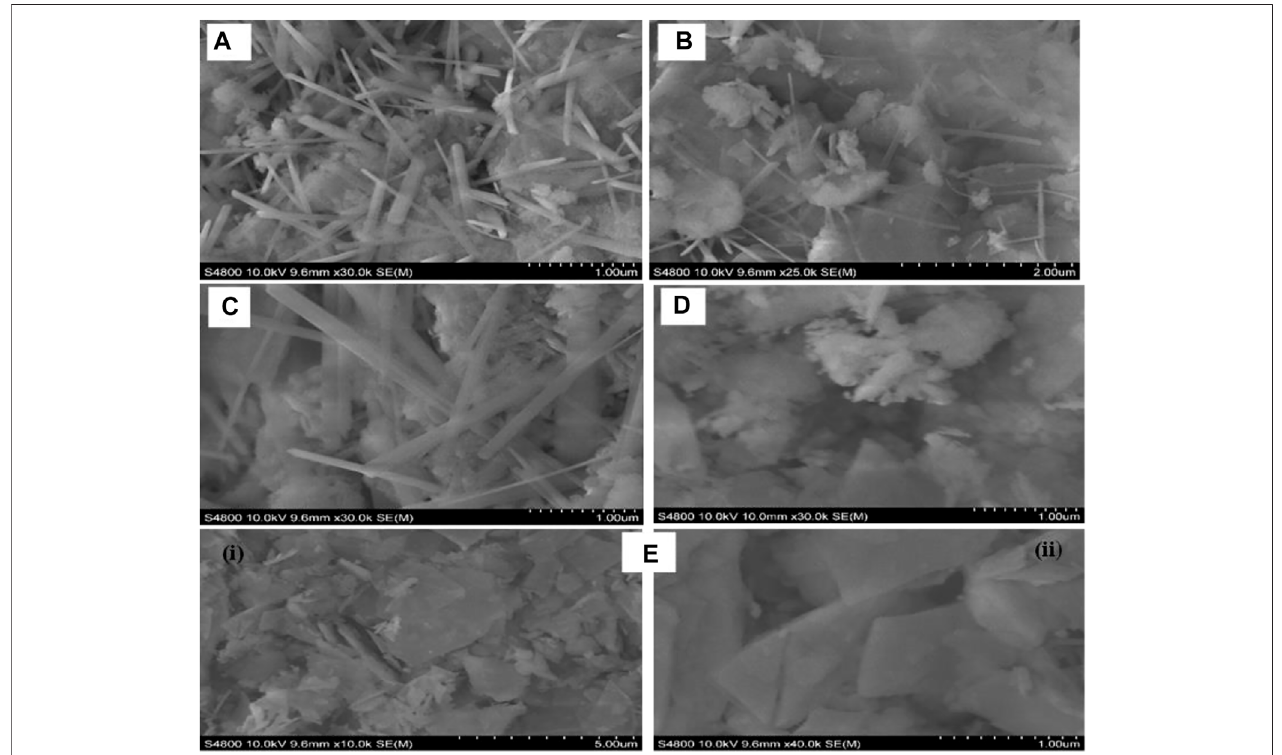
FIGURE 2 | SEM images of ZnS prepared with different amounts of NaBH 4 (A) 0 mol (B) 0.003 mol (C) 0.005 mol (D) 0.01 mol (E) 0.02 mol.